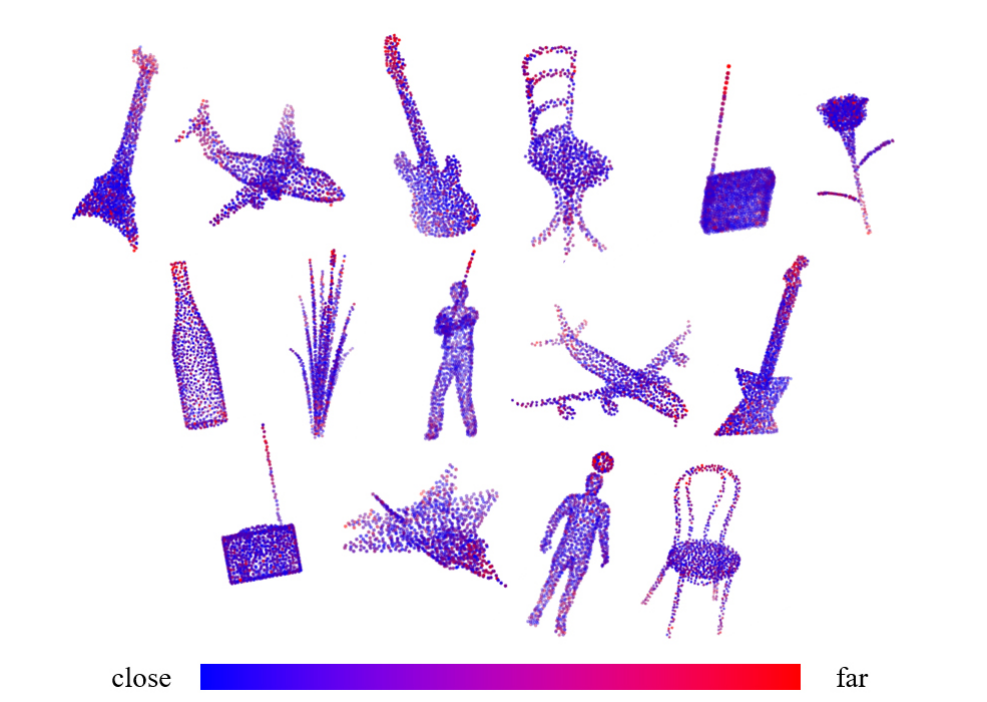
Figure 8. Reconstruction heatmap of GN-GAN. We first obtain the difference between each point in the ground truth and the reconstructed point cloud, and then the difference is projected onto the corresponding point of ground truth. The heat map is formed according to the difference.